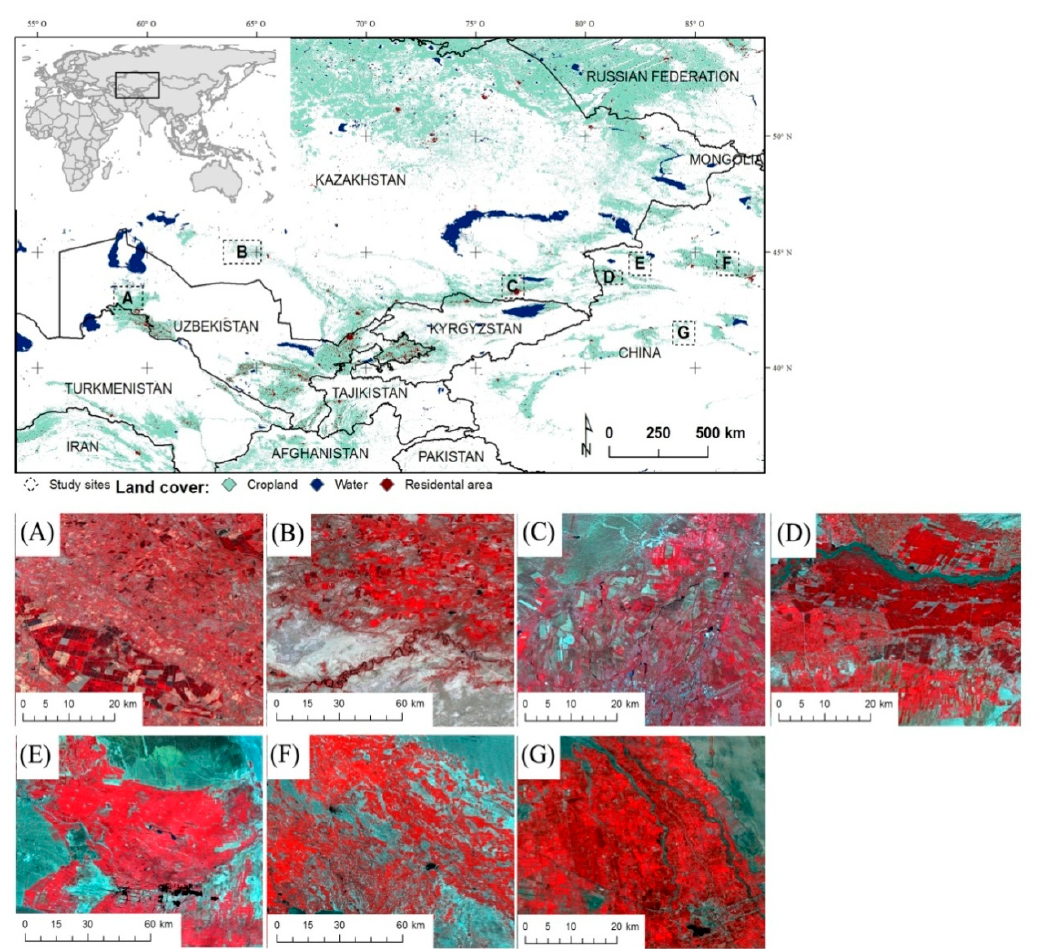
Figure 1. Study area. Note: Source of land cover classes: GLC global land cover of 2010 [14]. For the zoomed-in images: ( A ) fields in Karakalpakstan (KKP), ( B ) fields in Kzyl-Orda (KYZ), ( C ) fields in Almaty (ALM), ( D ) fields in Yining (YN), ( E ) fields in Bole (BL), ( F ) fields in Luntai (LT), and ( G ) fields in MNS. The land cover distributions in the upper sub-figure is based on FROM-GLC data. The zoomed-in sub-figures ( A – G ) are false color images from July 2016. These images have different scales because the field sizes in BL, MNS and KYZ are large, while, for the other regions, the fields are characterized as small. Thus, the zoomed-in images represent the different crop field